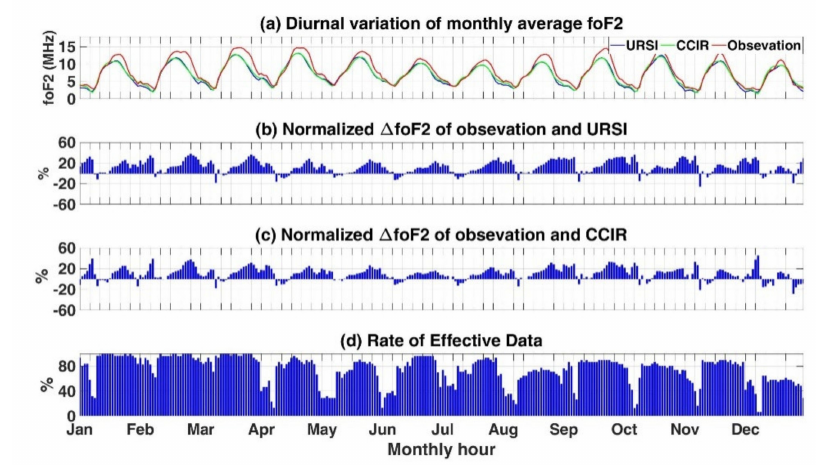
Figure 3. Diurnal variation of the monthly average of fo F2 from the IRI-2016 with the URSI and CCIR options and comparison of observed and modeled fo